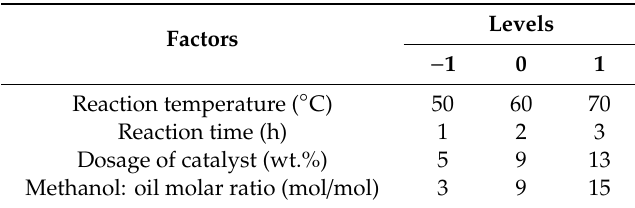
Table 1. Box − Behnken independent variables (coded and uncoded).